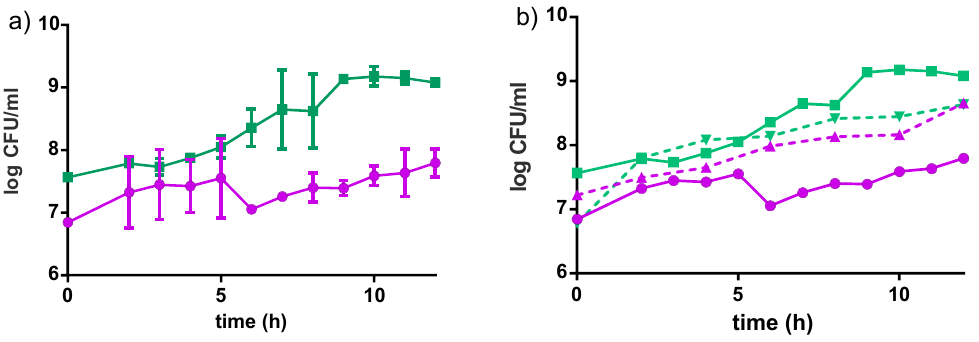
Figure 3. Growth curves of L. rhamnosus GR-1( ● ) and S. thermophilus C106 ( ■ ) populations when grown in ( a ) consortium (straight line); or ( b ) as single culture (dotted line) in milk. Fermentations were carried out at 40 °C for 12 h. Curves show mean values and error bars based on two independent replicates. Table 1. Maximum growth rate ( μ max ) of L. rhamnosus GR-1 and S. thermophilus C106 in media (M17, modified MRS) enriched with 0.5% of different carbon sources.